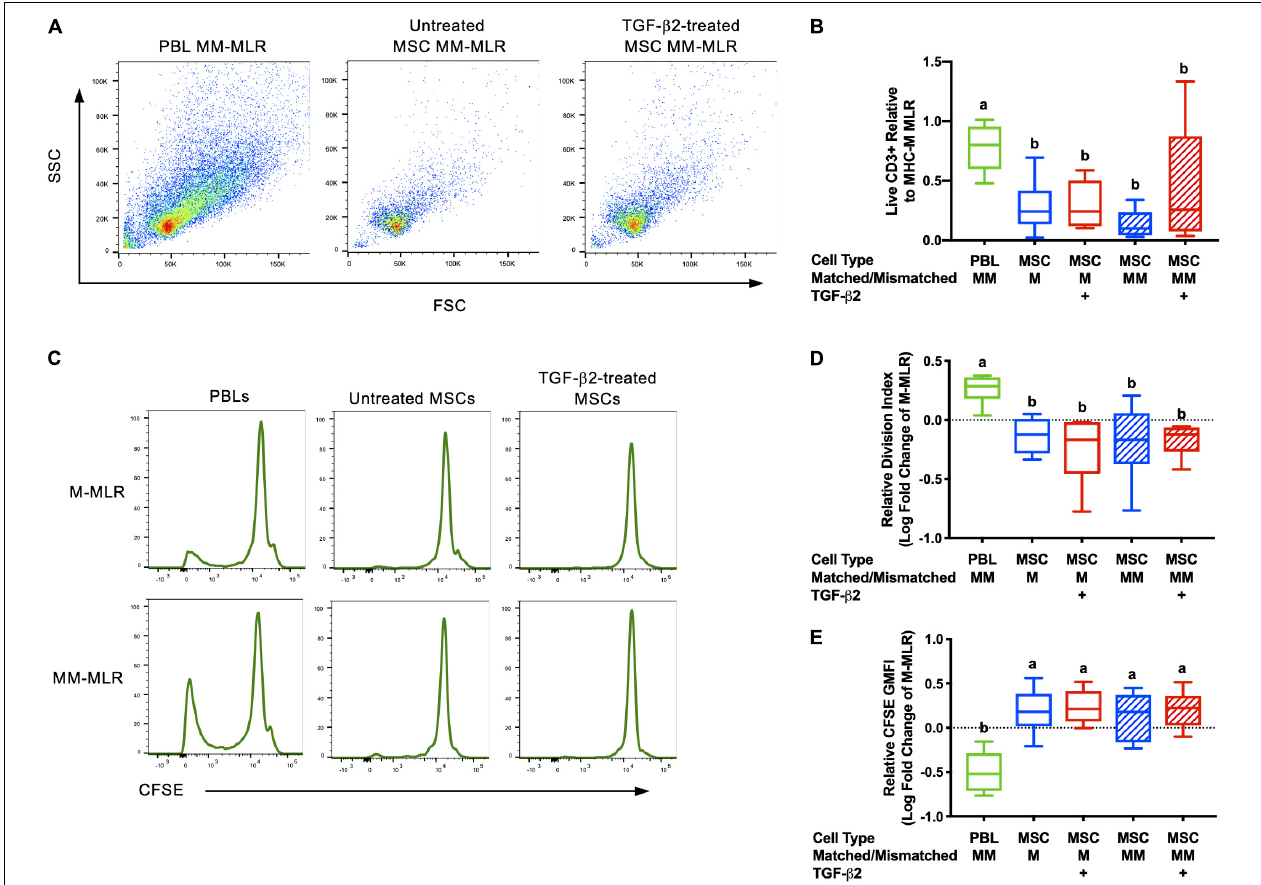
FIGURE 1 | Untreated and TGF- β 2-treated MSCs inhibit proliferation of MHC-mismatched T cells in vitro . (A) Representative dot plots of live, CD3 + cells from MLRs with MHC-mismatched PBL, untreated MSC, and TGF- β 2-treated MSC stimulator cells. (B) Number of live CD3 + cells recovered from MLRs relative to the MHC-M MLR with PBL stimulator cells. Data shown are mean ± SD of n = 6, p = 0.0046 by ANCOVA. Superscript letters indicate significant difference between groups by Tukey’s test. (C) Representative histograms depicting CFSE attenuation in responder PBLs cultured with MHC-matched (M) and MHC-mismatched (MM) PBL, untreated, and TGF- β 2-treated MSC stimulator cells. (D) Proliferation of live, CD3 + responder T cells shown as the average log fold change in division index relative to the MHC-M MLR with PBL stimulator cells. Data shown are mean, minimum, and maximum values of n = 6, p = 0.0025 by ANCOVA. (E) Proliferation of live, CD3 + responder T cells shown as the average log fold change in CFSE geometric mean fluorescent intensity relative to the MHC-M MLR with PBL stimulator cells. Data shown are mean, minimum, and maximum values for n = 6, p = 0.0001 by